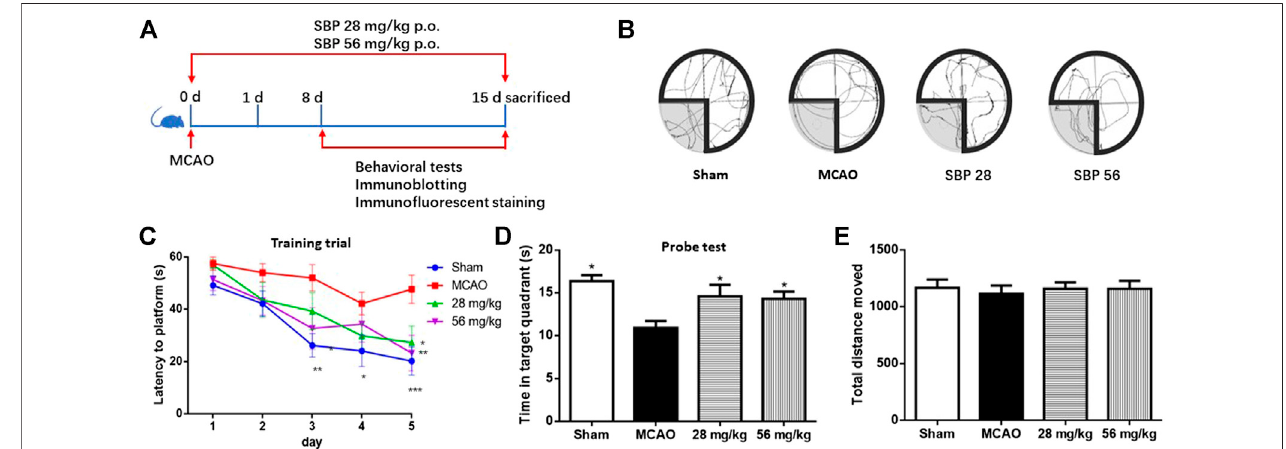
FIGURE 3 | SBP Improved Behavioural Effects on Cognitive Performance in Rats 14 days after Ischemia-Reperfusion Brain Injury. Effects of SBP in MCAO model ratsintheMorriswatermazetest. (A) Schematicrepresentationoftheexperimentaldesign. (B) representativeswimmingpath. (C) Escapelatencytothehiddenplatform